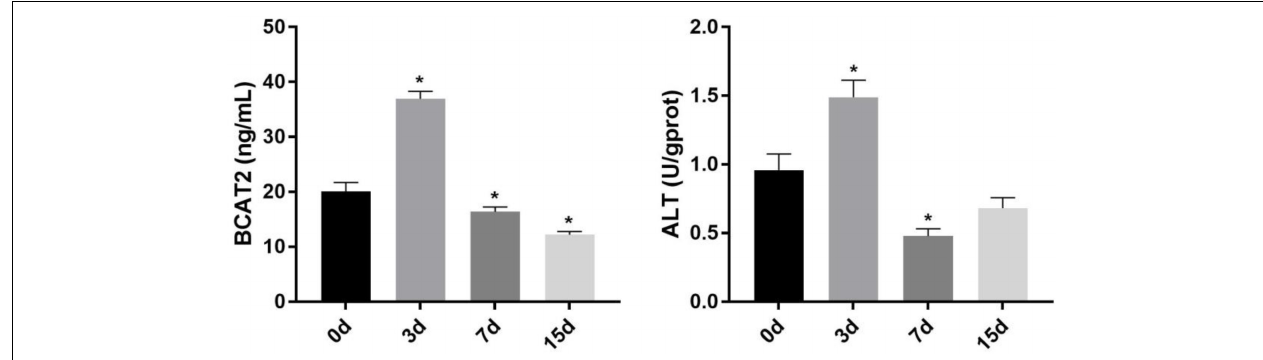
FIGURE 2 | Effect of starvation on the activity of BCAT2 and ALT in the skeletal muscle of Nile tilapia. Values represent the mean ± SE ( n = 9 fish, 3 fish were sampled for each tank). * p < 0.05 significantly different vs. 0 day. ALT, alanine aminotransferase.